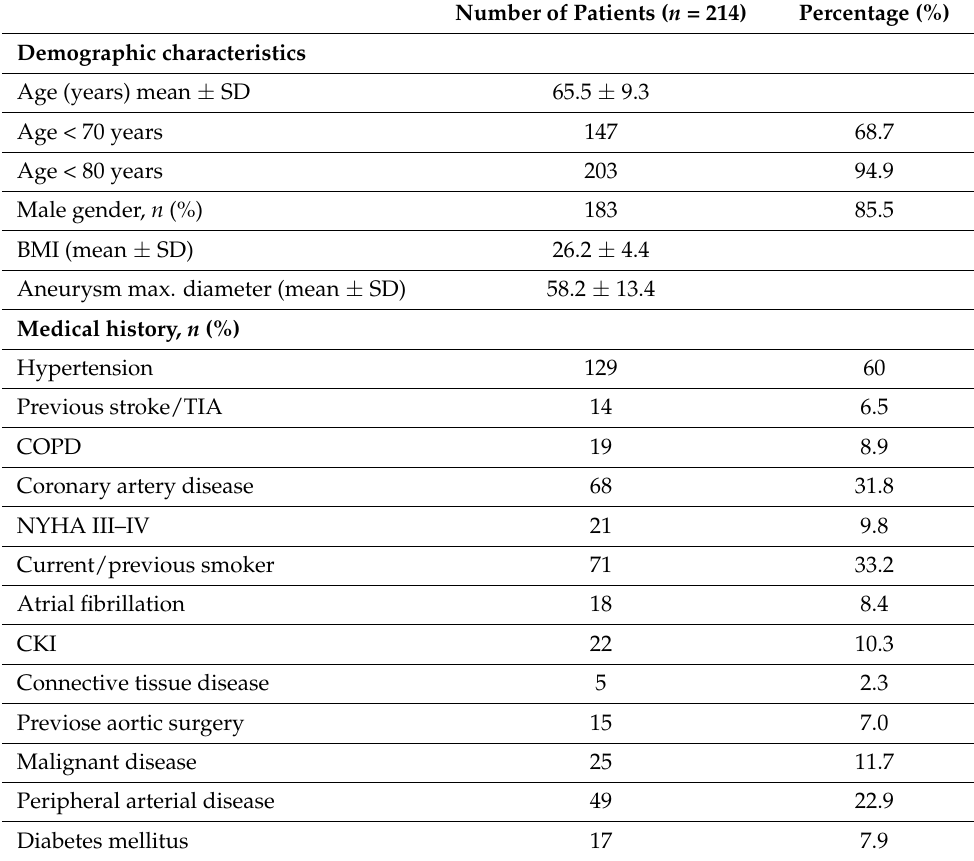
Table 2. Baseline characteristics of the study